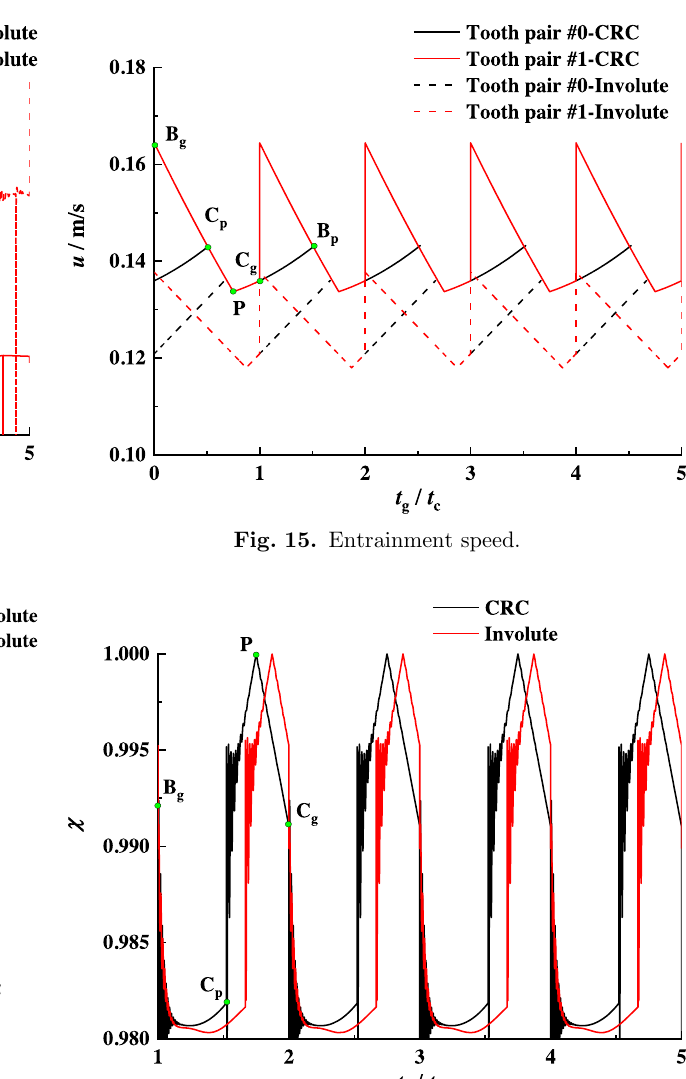
Fig. 16. Mechanical ef fi